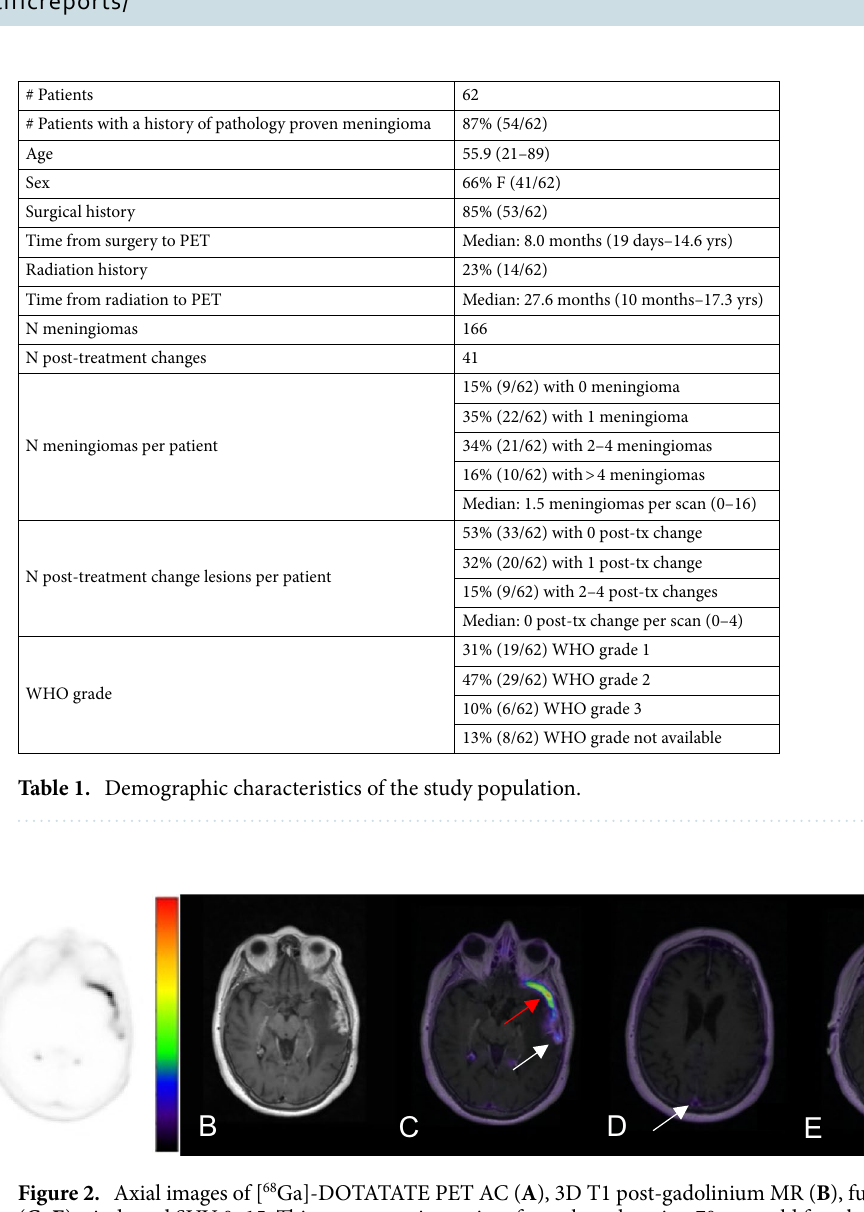
Figure 2. Axial images of [ 68 Ga]-DOTATATE PET AC ( A ), 3D T1 post-gadolinium MR ( B ), fused PET/MR T1 ( C – E ) windowed SUV 0–15. This representative patient from the cohort is a 70-year-old female with a history of WHO grade II meningioma s/p resection and proton therapy 6 years prior to imaging and an additional proton therapy a year prior. The fused PET/MR images demonstrate a lesion suspicious for a meningioma in the left anterior temporal pole with SUV of 13.6 ( C , red arrow). The more posteriorly located enhancing lesion ( C , white arrow) demonstrates SUV of 4.5 and was suspicious for post-treatment change, given that the SUV of the superior sagittal sinus was 2.3. The subsequent resection and biopsy of the two lesions a year later confirmed the suspected diagnosis of recurrent meningioma and radiation necrosis, respectively. The superior sagittal sinus ( D , arrow) demonstrates SUV of 2.3 and the pituitary gland ( E ) demonstrates SUV of